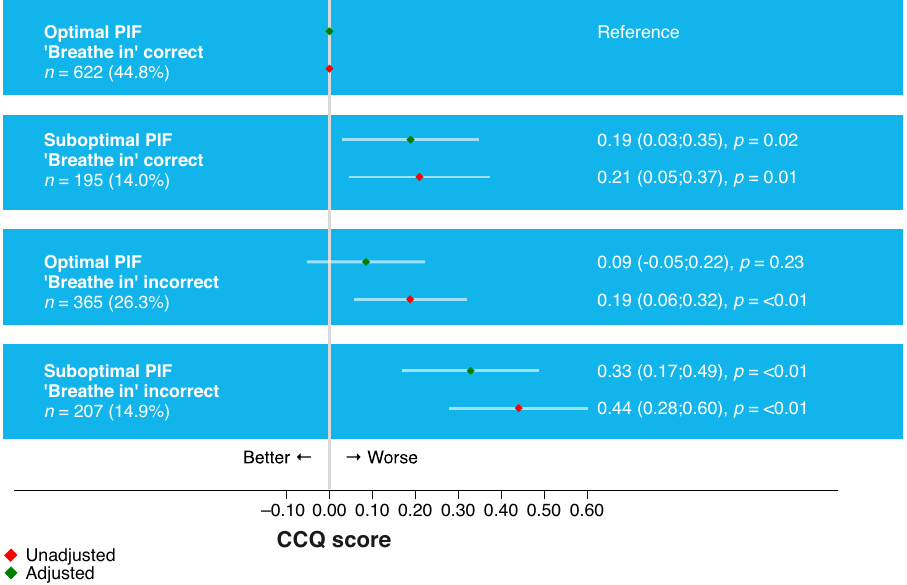
Fig. 3 Association of PIF and ‘ Breathe in ’ error with health status (CCQ score). Regression model adjusted for the following confounders: Country of residence, Anxiety, Medication Regimen, Smoking status, Device resistance, BMI, Diabetes, Sex. Table 2. The association between deliberate non-adherence and low Peak Inspiratory Flow. Resistance cluster